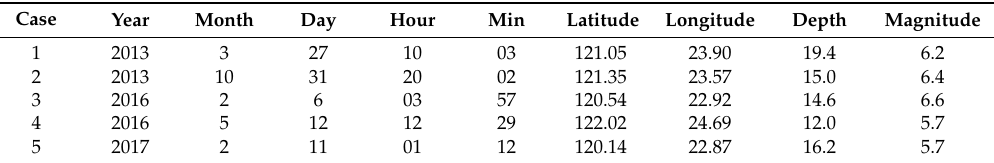
Table 3. Catalog of the earthquakes used in this study.